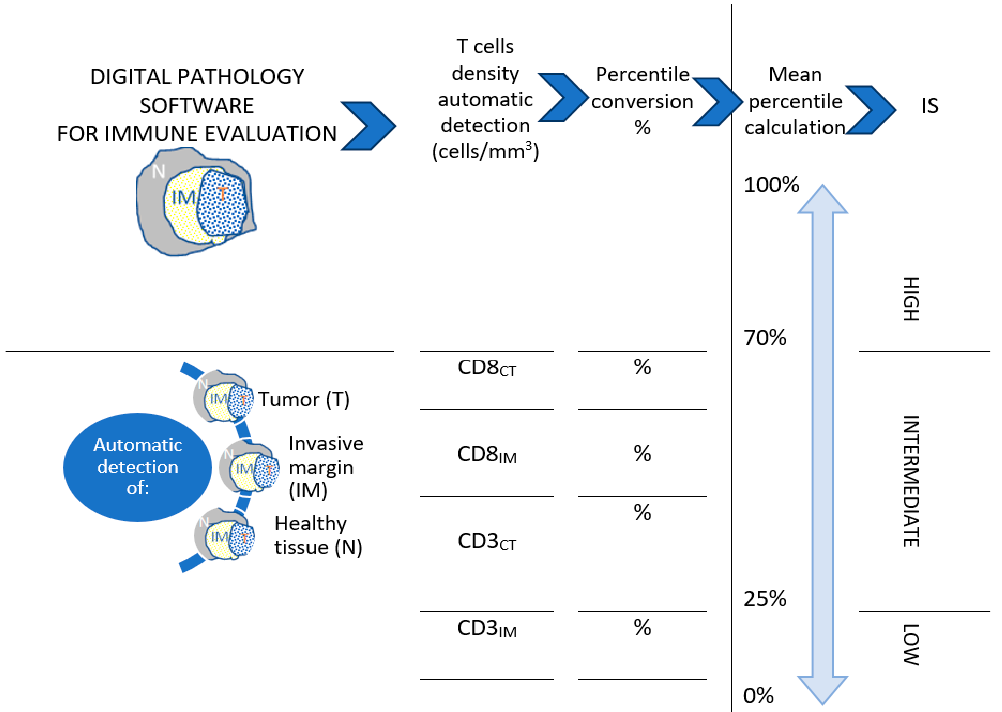
Figure 1. Diagrammatic presentation of immunoscore (IS) determination.